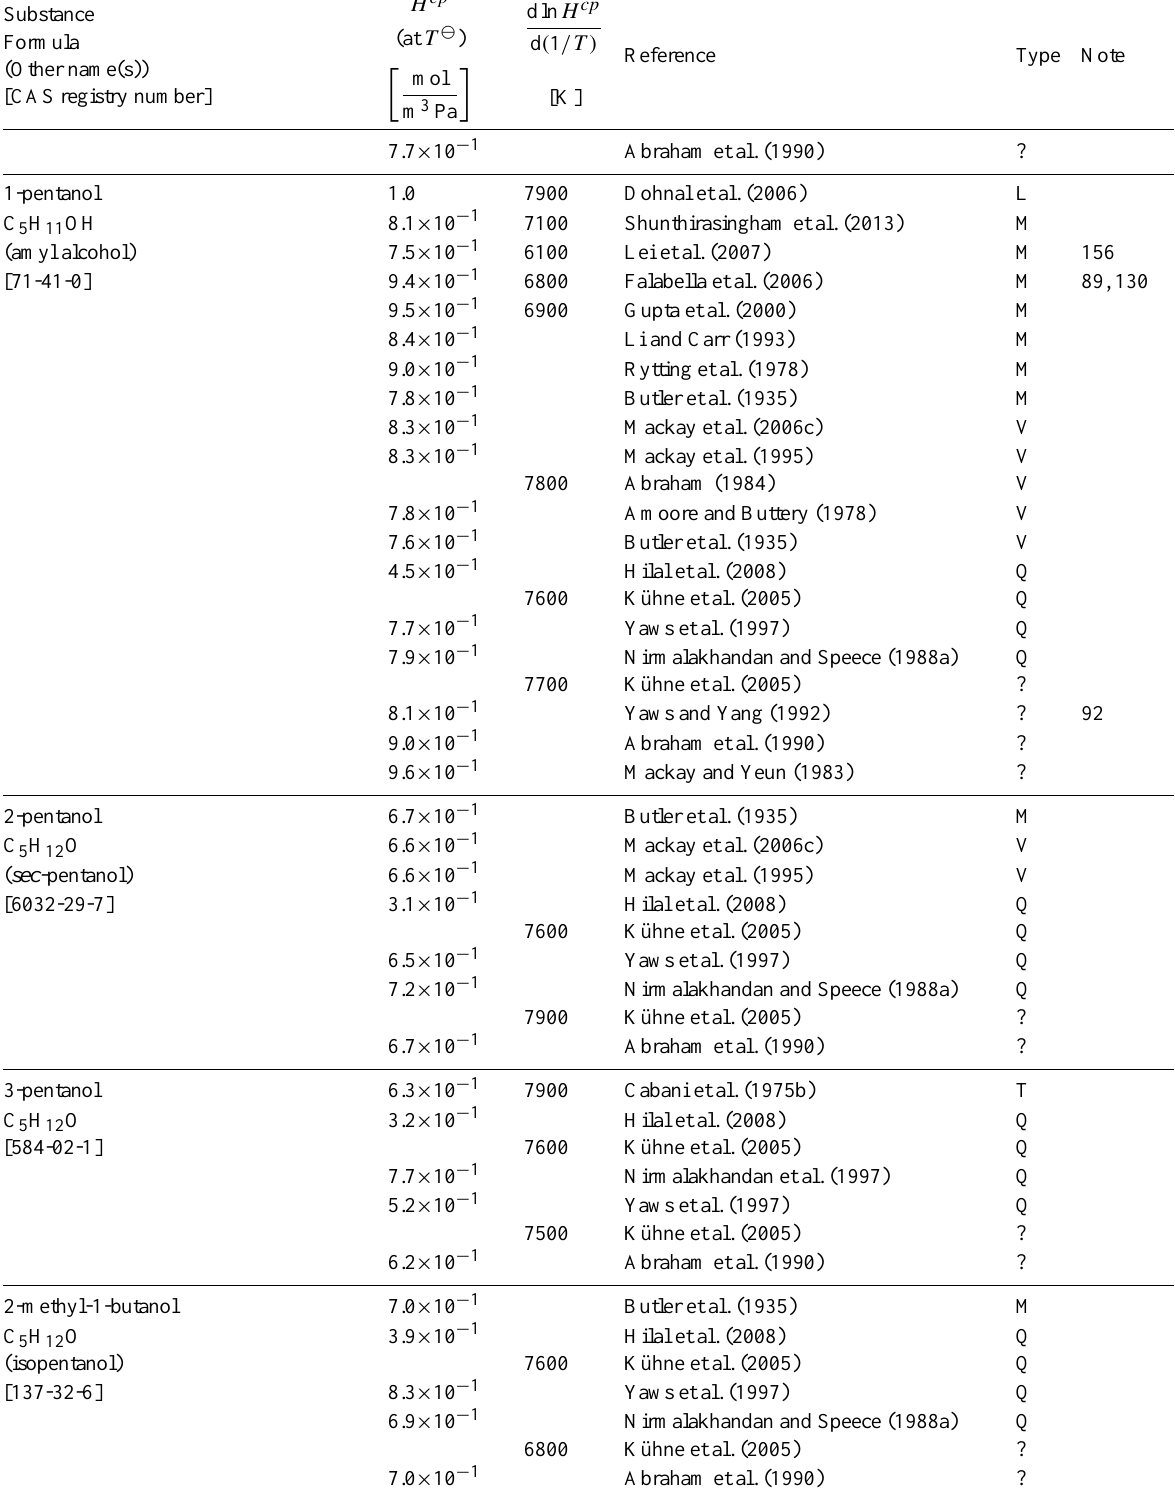
Table 6: Henry’s law constants for water as solvent